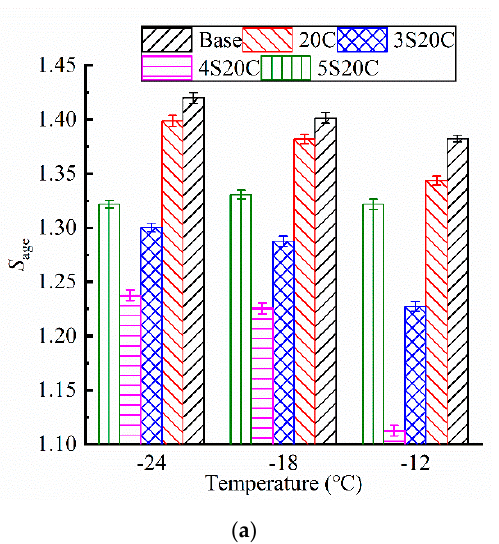
Figure 8. Complex modulus aging index ( C age ) of asphalt samples: ( a ) with different nano-SiO 2 , and ( b ) with different rubber powder.